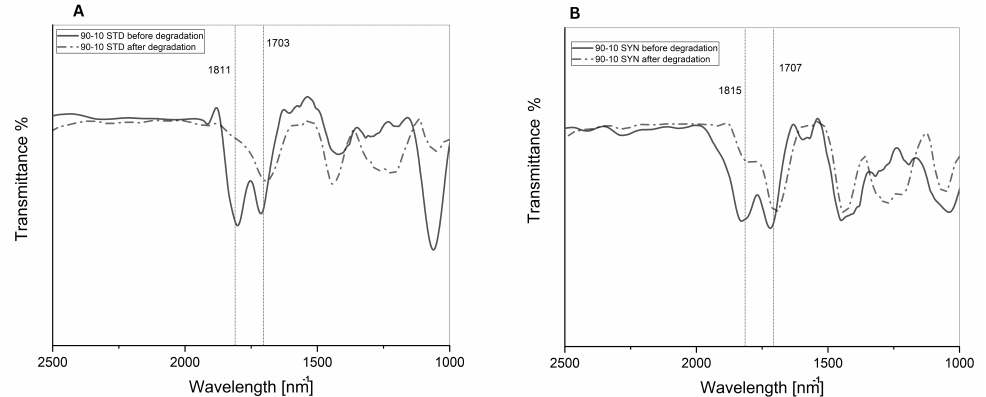
Figure 11. ( A ) Anhydride bond degradation in sample STD (90:10). ( B ) Anhydride bond degradation in sample SYN (90:10).